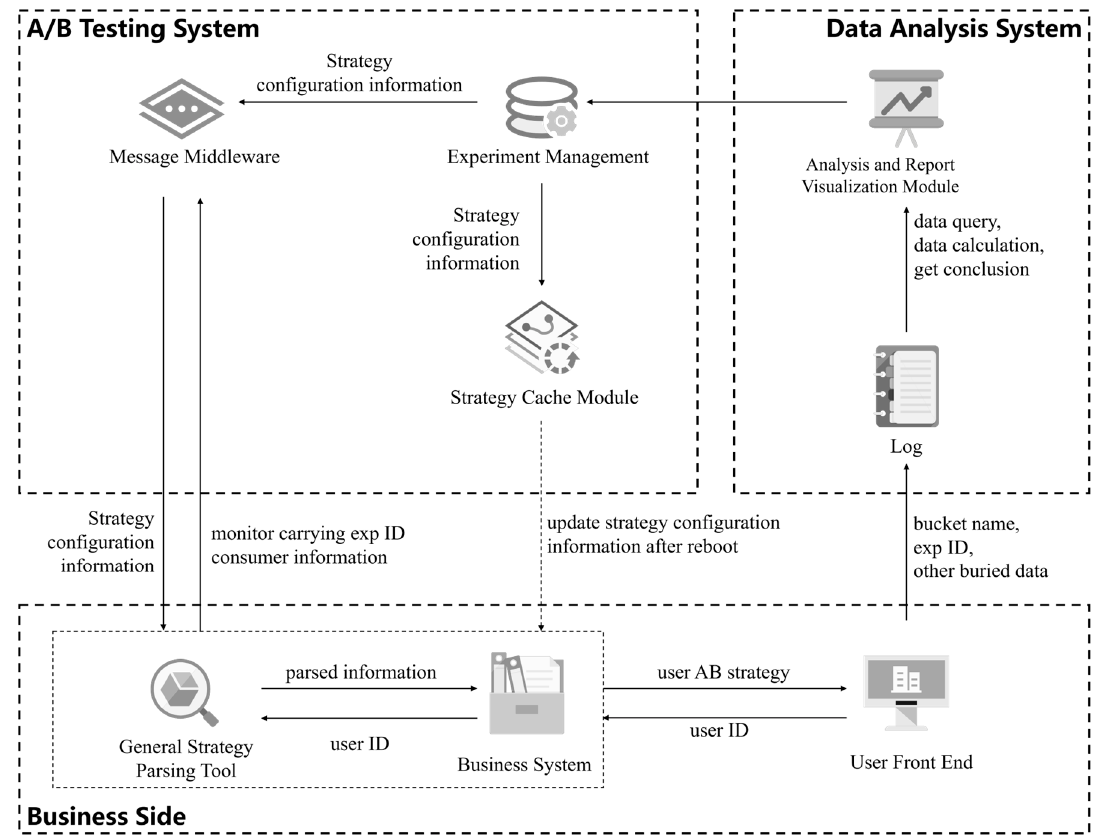
Figure 1. System Figure 1. System model.